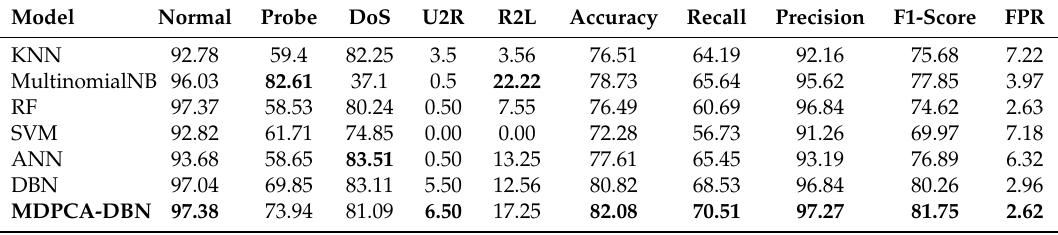
Table 10. Comparison results for the NSL-KDD (KDDTest+) dataset (%).